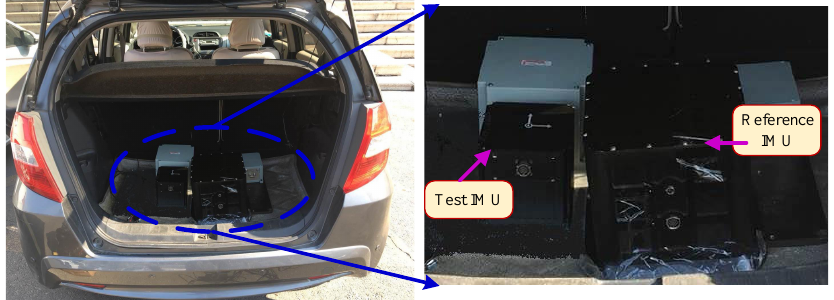
Figure 7. Dynamic test in a car. In this test, a high-precision FOG SINS was used as a reference to provide the attitude reference while a low-accuracy FOG IMU was used to be tested. The sampling frequency is 100 Hz and the testing time is about 1